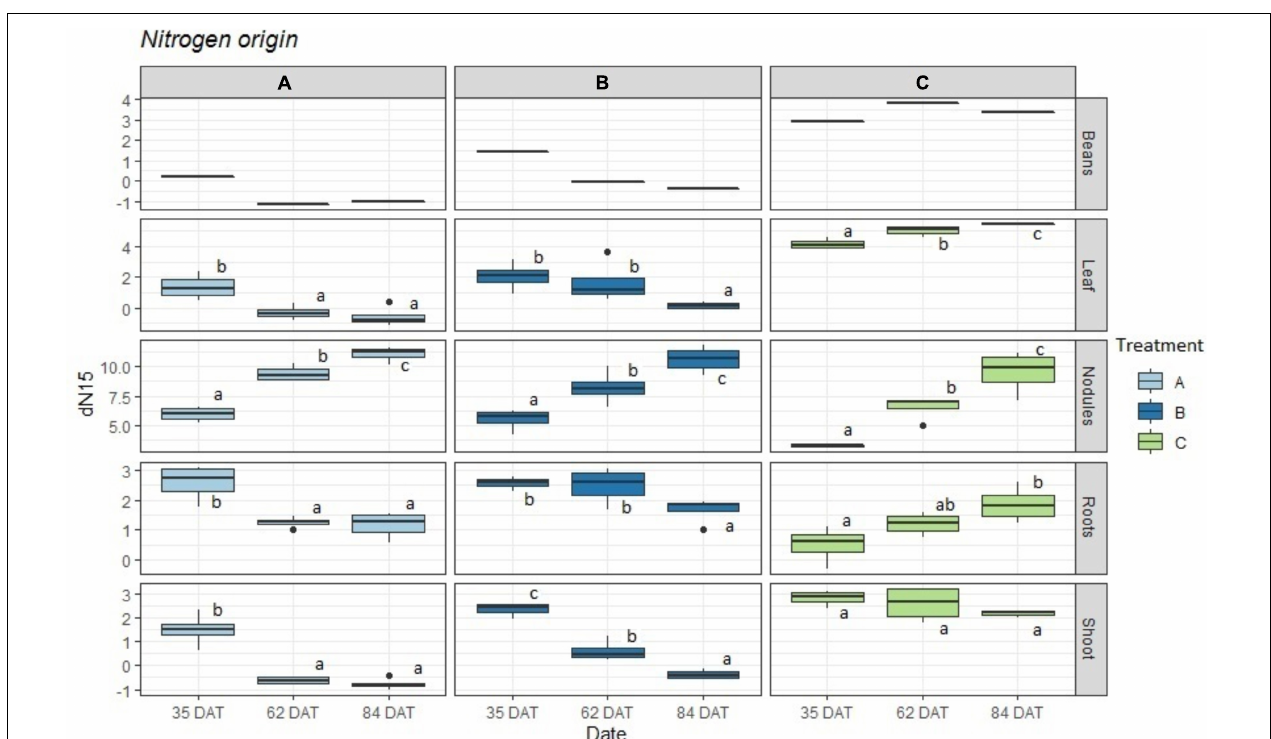
FIGURE 2 | Boxplot representing the obtained δ 15 N values ( n = 4) for treatments: A = 2g of struvite + Rhizobium inoculation + P, Mg, N-free nutrient solution, B = 5g of struvite + Rhizobium inoculation + P, Mg, N-free nutrient solution and C = standard nutrient solution - Rhizobium inoculation. These observed values are given by plant organs in three different time periods: 35 days after transplanting, 62 days after transplanting, and 84 days after transplanting. Significant differences ( p < 0.05) between dates marked with different letter